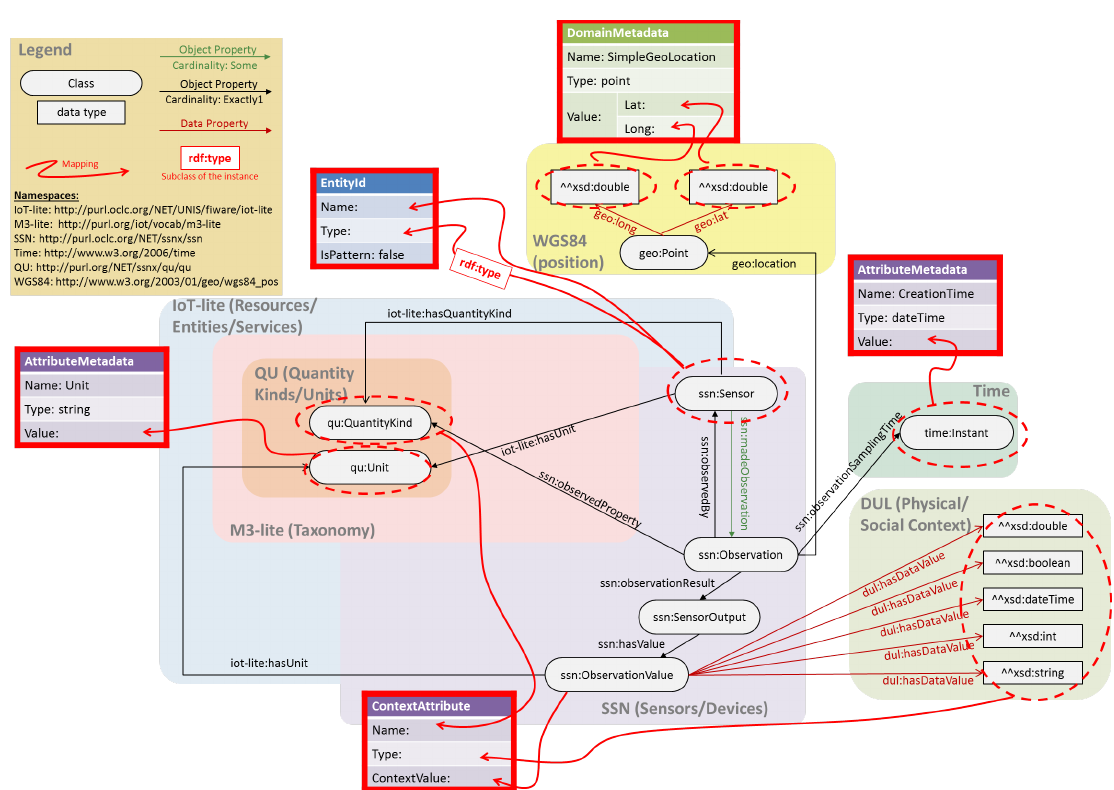
Figure 4. Combining the context management interface standard OMA NGSI with semantics offered by the FIESTA-IoT